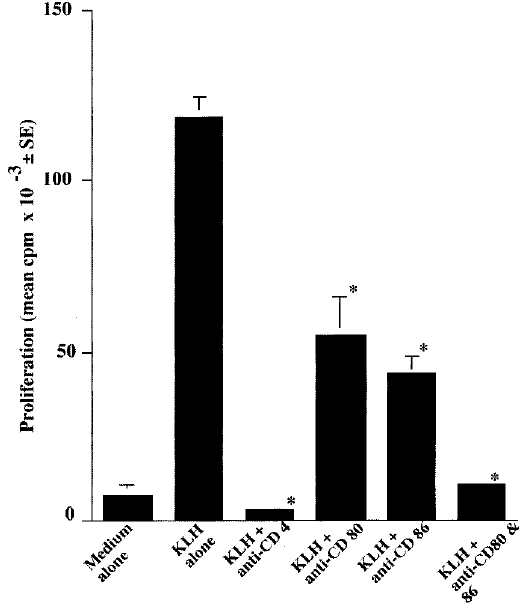
FIG. 3. Suppressive activity of anti-CD80 and anti-CD86 monoclonal antibodies on antigen-induced spleen cell pro- liferation. BALB/c mice were immunized by intraperitoneal injection with 8.0 m g/ml of hemocyanin (KLH) absorbed to 4.0mg of aluminium hydroxide in a volume of 0.5ml. Spleen cells prepared 10 days later were cultured with either anti- CD80 or anti-CD86, or anti-CD80 and anti-CD86 for 72h, which were stimulated with 100.0 m g/ml of KLH. The cell prolifera- tion was assessed by measuring incorporation of 1.0 m Ci of 3 H-thymidine for 8h. The results were expressed as mean cpm ± standard error of five individual mice. *Significant at p < 0.001 as compared with KLH alone.